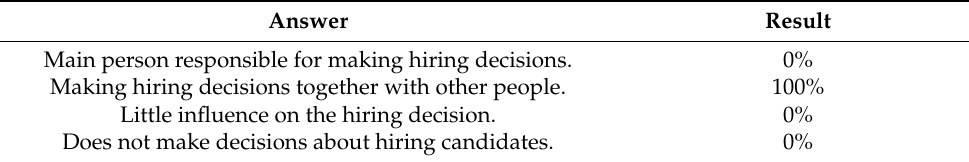
Table 2. Are you the person responsible for making hiring decisions in the company? Answer Result Main person responsible for making hiring decisions.